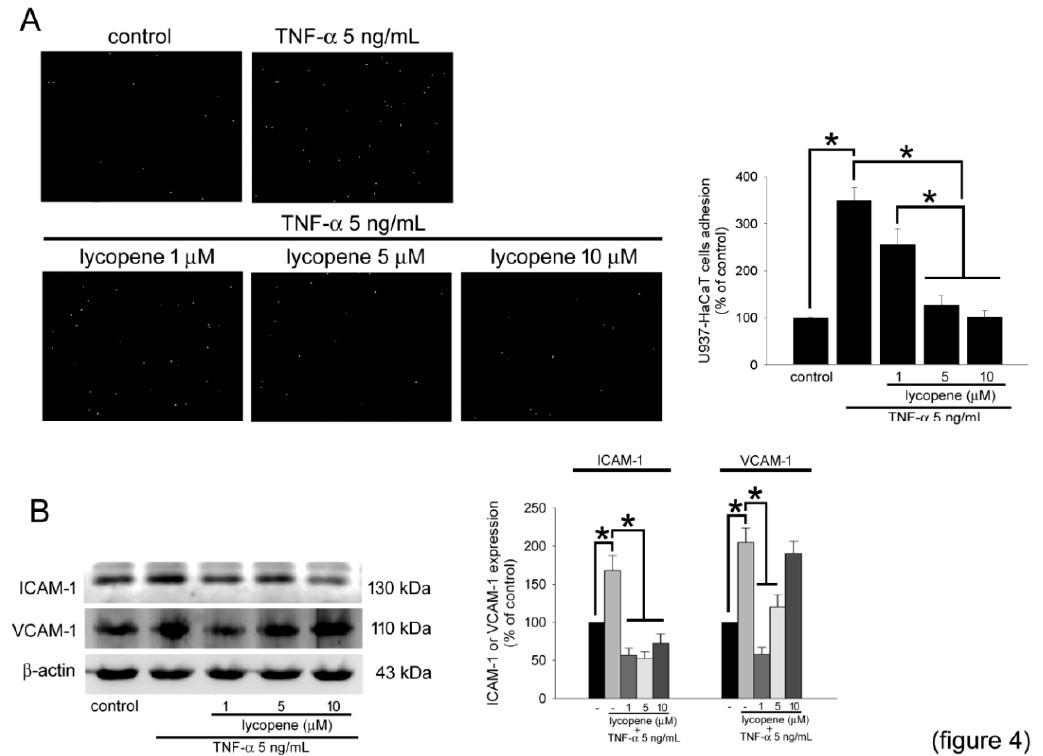
Figure 4. Lycopene inhibits U937 cell adhesion and adhesion molecule expression in TNF- α -stimulated HaCaT cells. ( A ) HaCaT cells were pretreated with 1–5 μ M lycopene for 24 h and treated with 5 ng/mL TNF- αα for 4 h. After incubation of BCECF/AM-labeled U937 cells for 1 h, the adhesion of fluorescent U937 cells was observed using fluorescence microscopy. The bar graph shows the quantification of the adherent U937 cells. ( B ) HaCaT cells were treated with 5 ng/mL TNF- α for 4 h with or without preincubation with 1–5 μ M lycopene. The Western blot analysis was conducted to analyze the extracted total protein. The loading control was used by β -actin. Densitometer was used to quantify the density of each band. The results are expressed as the mean ± SD. * p < 0.05 was considered significant difference, n = 3.